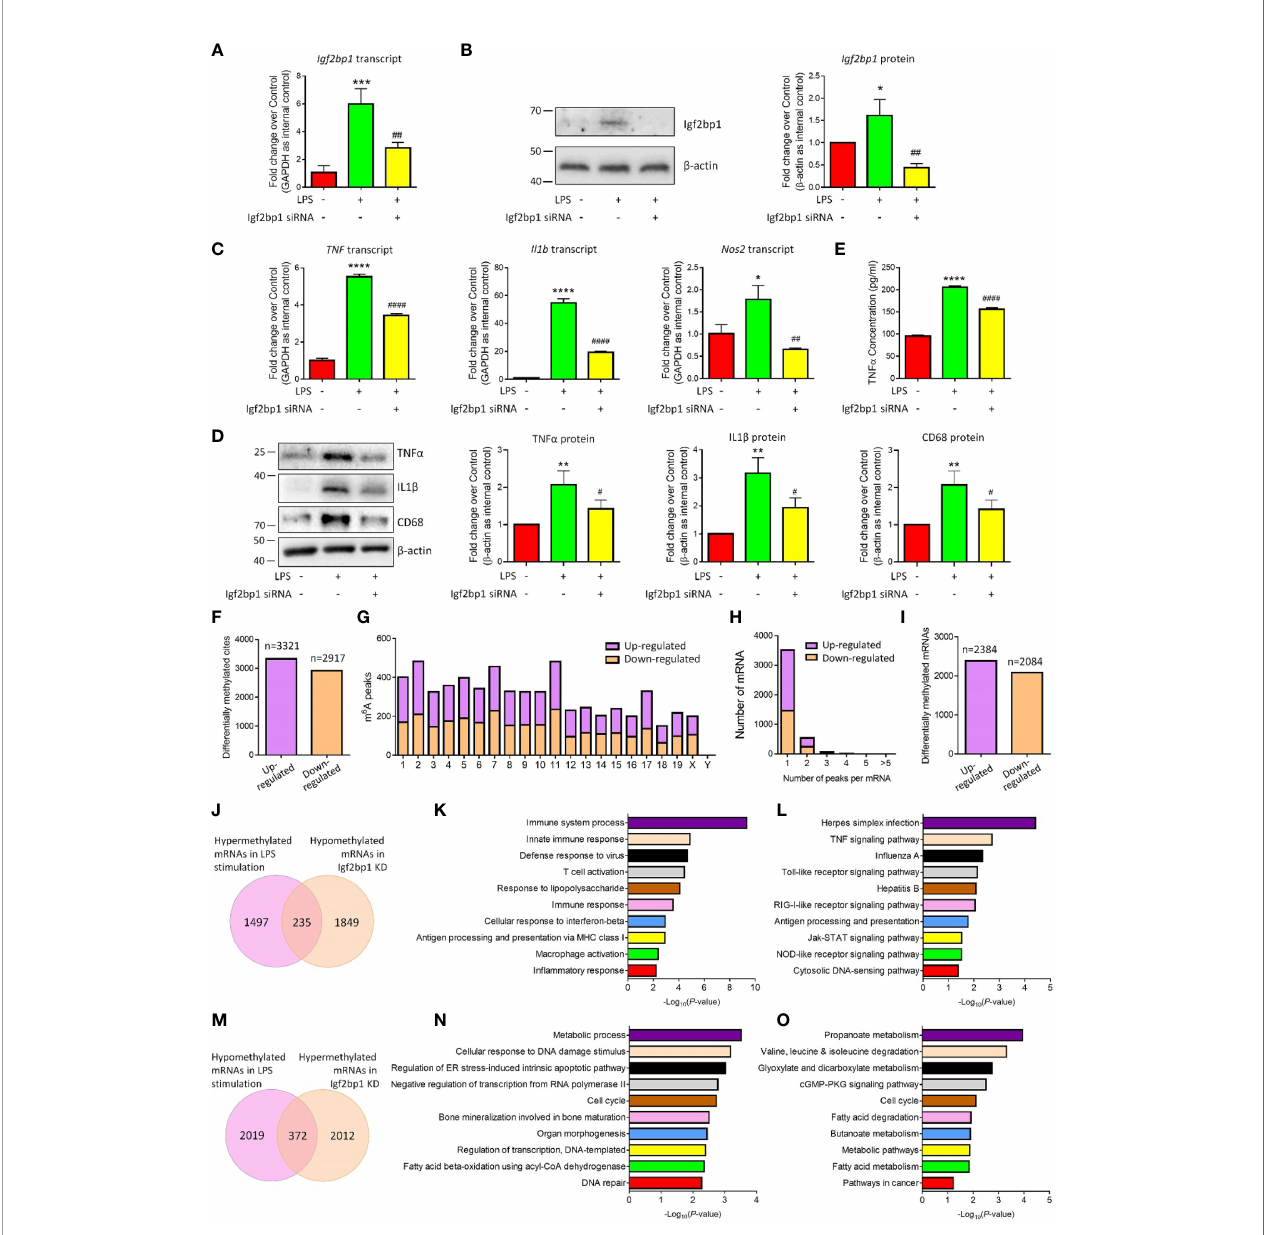
FIGURE 3 | Igf2bp1 regulates the in fl ammatory responses and m6A modi fi cations of microglia. (A) Expression of Igf2bp1 mRNAs in LPS-stimulated microglia after knocking down Igf2bp1 expression was determined by qRT-PCR. (B) Expression of Igf2bp1 proteins in LPS-stimulated microglia after knocking down Igf2bp1 expression was determined by western blotting. (C) Expression of TNF , Il1b , and Nos2 mRNAs in LPS-stimulated microglia after knocking down Igf2bp1 expression was determined by qRT-PCR. (D) Expression of TNF a , IL1 b , and CD68 proteins in LPS-stimulated microglia after knocking down Igf2bp1 expression was determined by western blotting. (E) The release of TNF a from LPS-stimulated microglia after knocking down Igf2bp1 expression was determined by ELISA assay. (F) The numbers of signi fi cantly altered m6A peaks after knocking down Igf2bp1 expression in LPS-stimulated microglia. (G) The distributions of altered m6A peaks in human chromosomes. (H) The distribution of altered m6A peaks per mRNA. (I) The numbers of mRNAs with signi fi cantly altered m6A peaks after knocking down Igf2bp1 expression in LPS- stimulated microglia. (J) Venn diagrams for genes with m6A hypermethylation after LPS treatment and m6A hypomethylation post Igf2bp1 LOF. (K) The top 10 GO terms of genes with m6A hypermethylation after LPS treatment and m6A hypomethylation post Igf2bp1 LOF. (L) The top 10 KEGG pathways of genes with m6A hypermethylation after LPS treatment and m6A hypomethylation post Igf2bp1 LOF. (M) Venn diagrams for genes with m6A hypomethylation after LPS treatment and m6A hypermethylation post Igf2bp1 LOF. (N) The top 10 GO terms of genes with m6A hypomethylation after LPS treatment and m6A hypermethylation post Igf2bp1 LOF. (O) The top 10 KEGG pathways of genes with m6A hypomethylation after LPS treatment and m6A hypermethylation post Igf2bp1 LOF. Data were represented as mean ± s.d. from three independent experiments. *, **, ***, and **** denote p < 0.05, p < 0.01, p < 0.001, and p < 0.0001, respectively, in comparison with control microglia. #, ##, and #### denote p < 0.05, p < 0.01, and p < 0.0001, respectively, in comparison with LPS-stimulated